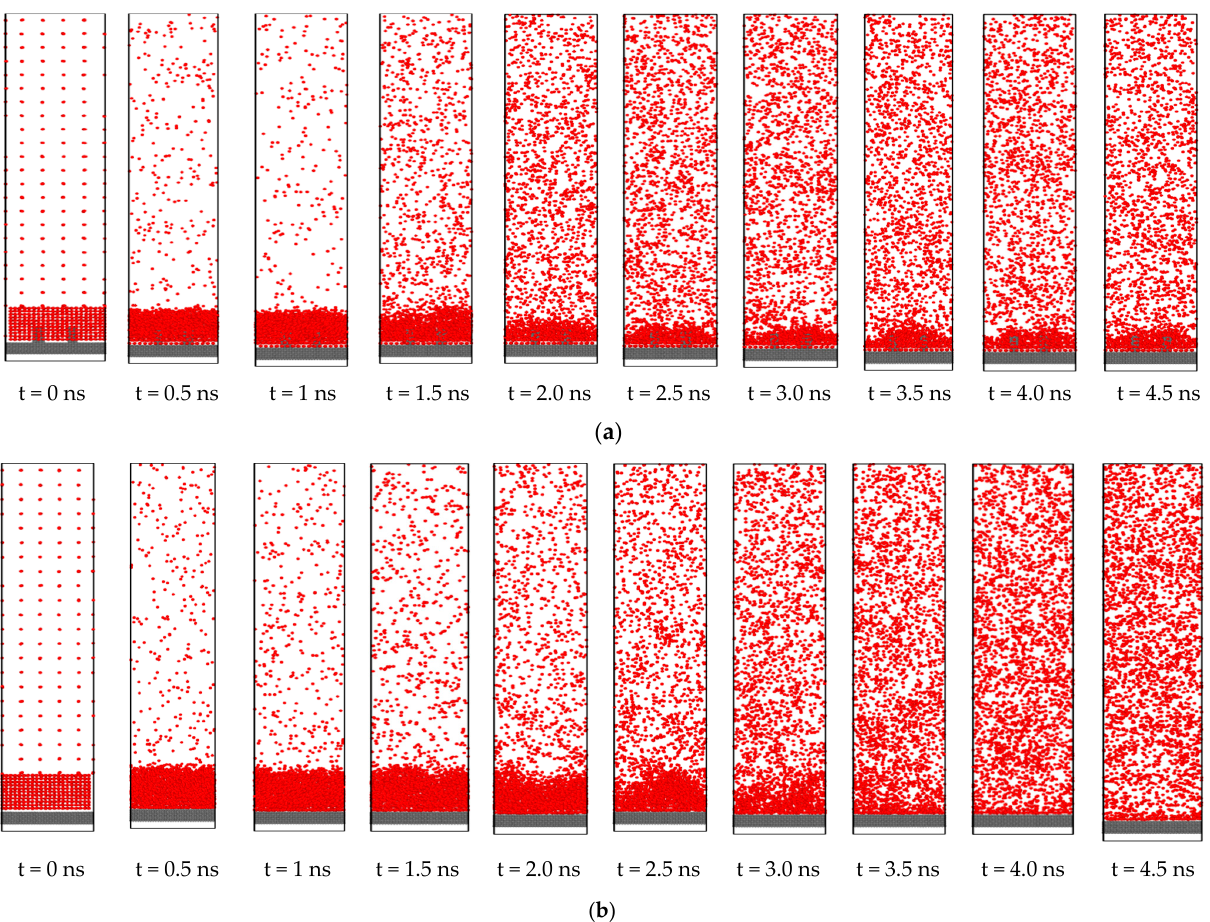
Figure 10. Snapshots from the simulation domain ( x – y plane) for ( a ) surface with nano structure ( b ) smooth surface.